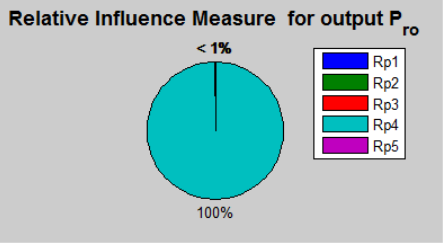
Figure 10. Relative influence measure ρ i for output P ro in reheater